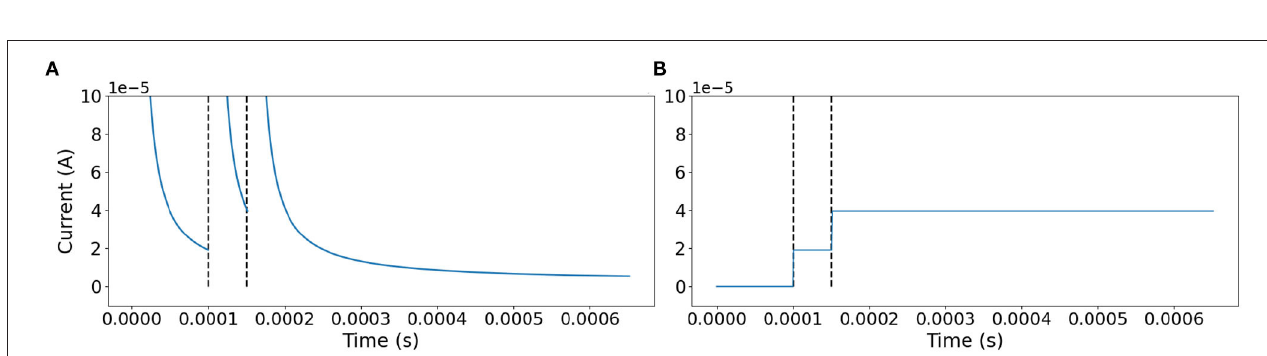
FIGURE 4 | Tuning curve of the used circuit. Marks shows measurements frequencies obtained by sweeping the current I in of Equation (1) in interval 0 − 300 µ A , with electrical and timing parameters: C mem = 1 µ F , R leak = 10 k (cid:127) , and a refractory period of 10 µ s . The orange line shows approximation by 7. * refers to the measured frequency of spikes. - refers to measurments approximation made by Equation (6).